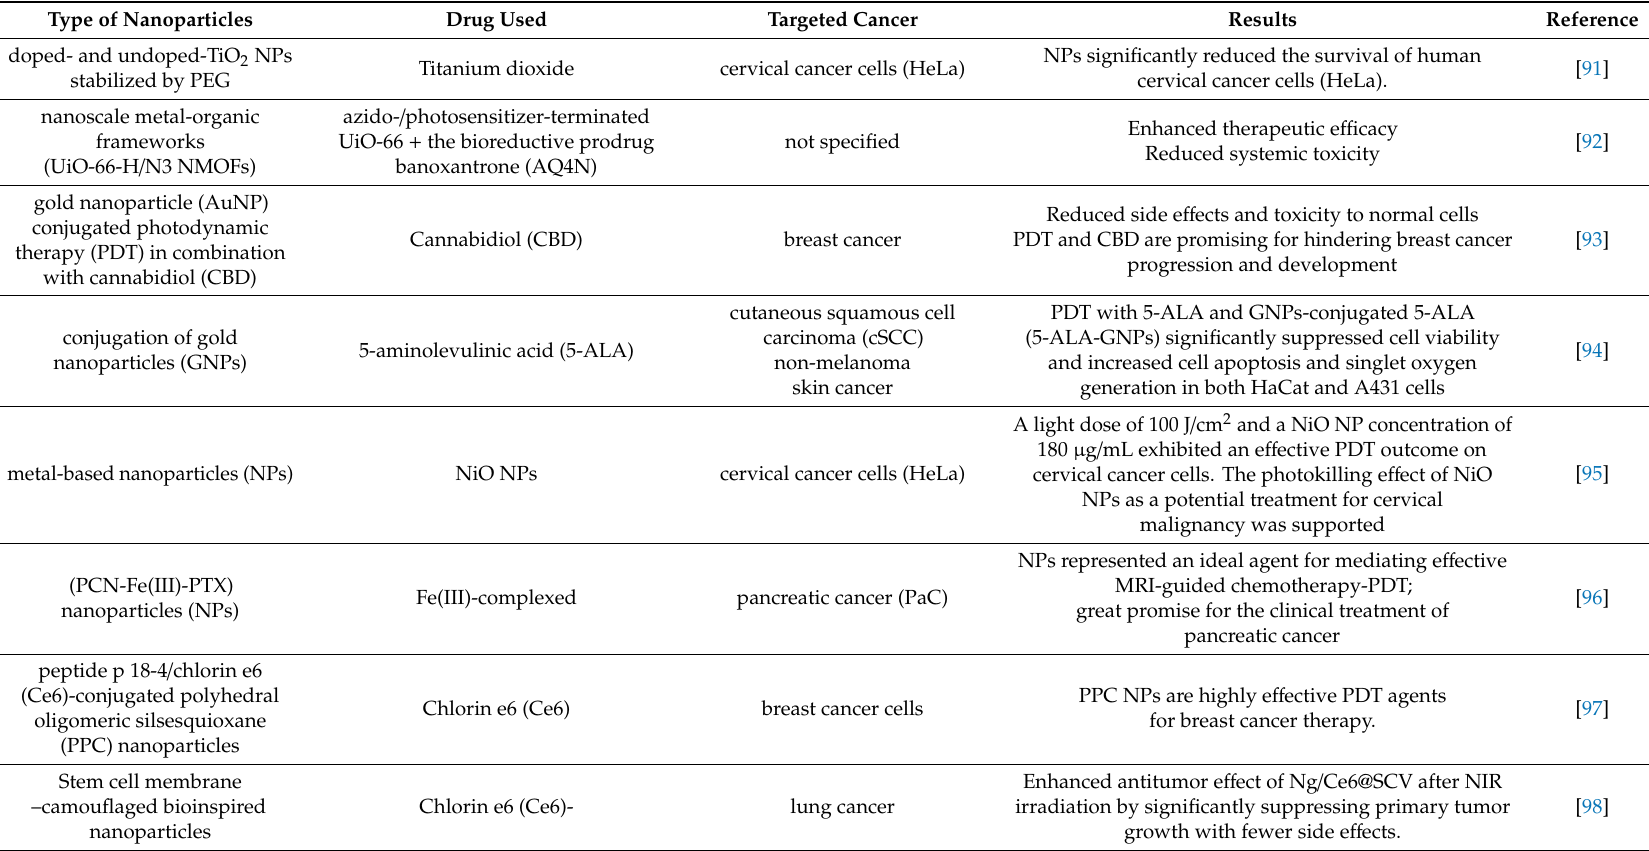
Table 3. Types of nanoparticles used to enhance the e ffi cacy of photodynamic